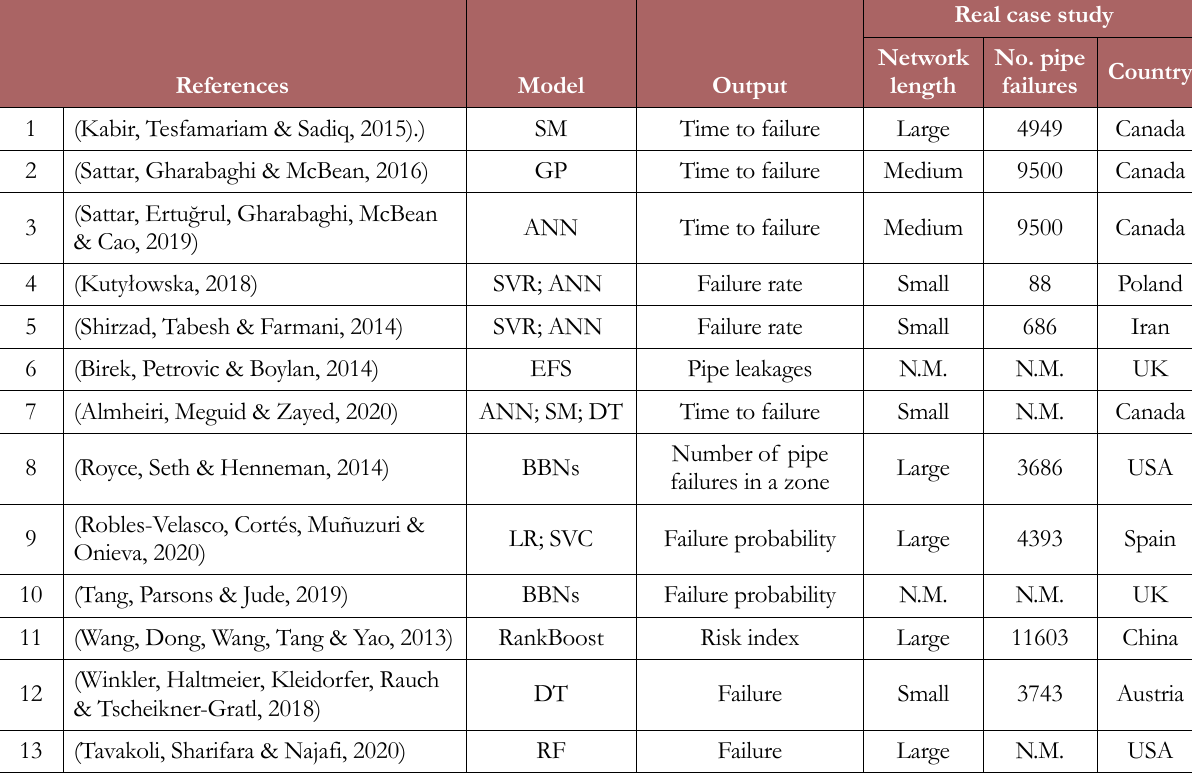
Table 1. References, models, output variables and their case